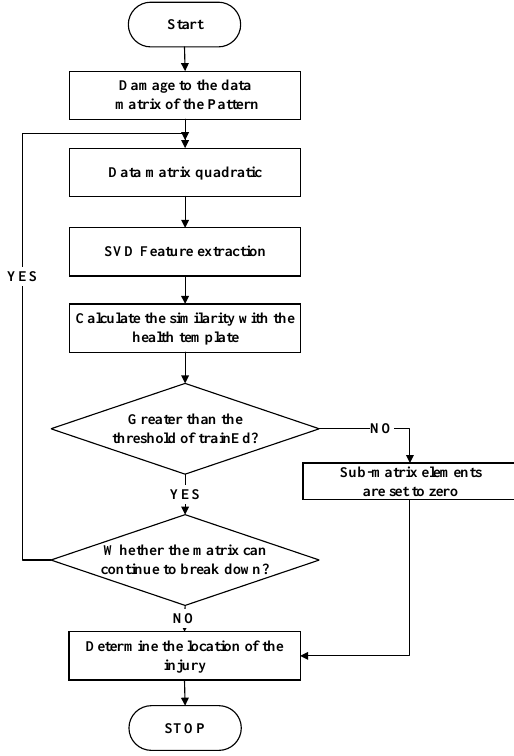
Figure 6. Flow chart of the SVD algorithm of the four-block matrix.